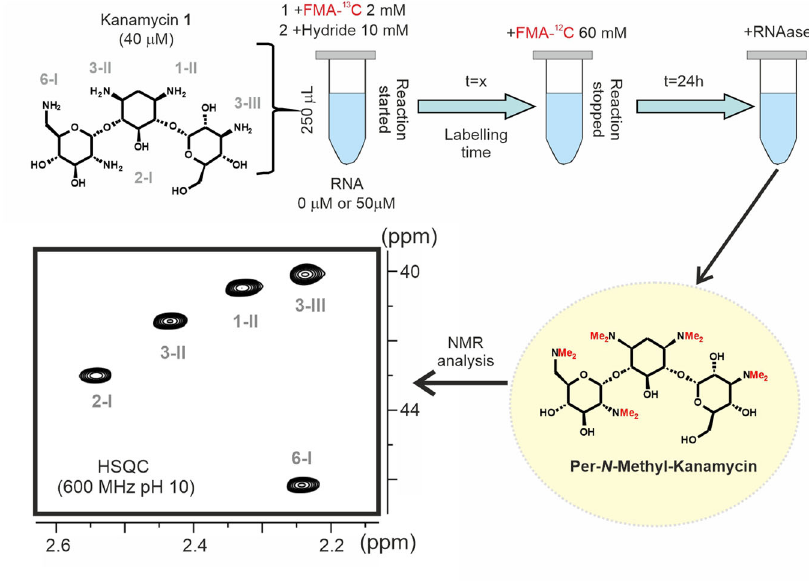
Fig. 2 Experimental protocol to measure protection factors. Schematic representation of the strategy employed to derive protection factors (protocol 1). N - Methylation reactions of kanamycin-B ( 1 ) with 13 C-formaldehyde (FMA) were carried out with both the free (-RNA) and complexed ( + RNA) ligand. After a variable labelling time ( t = x), aliquots were taken and treated with a large excess of unlabelled reagent to yield a single per- N -methyl derivative. Finally, RNA receptor is digested and the samples submitted to HSQC NMR analysis (spectrum shown corresponds to the resulting per- N -methyl-kanamycin at pH 10.0, where the assignment is also